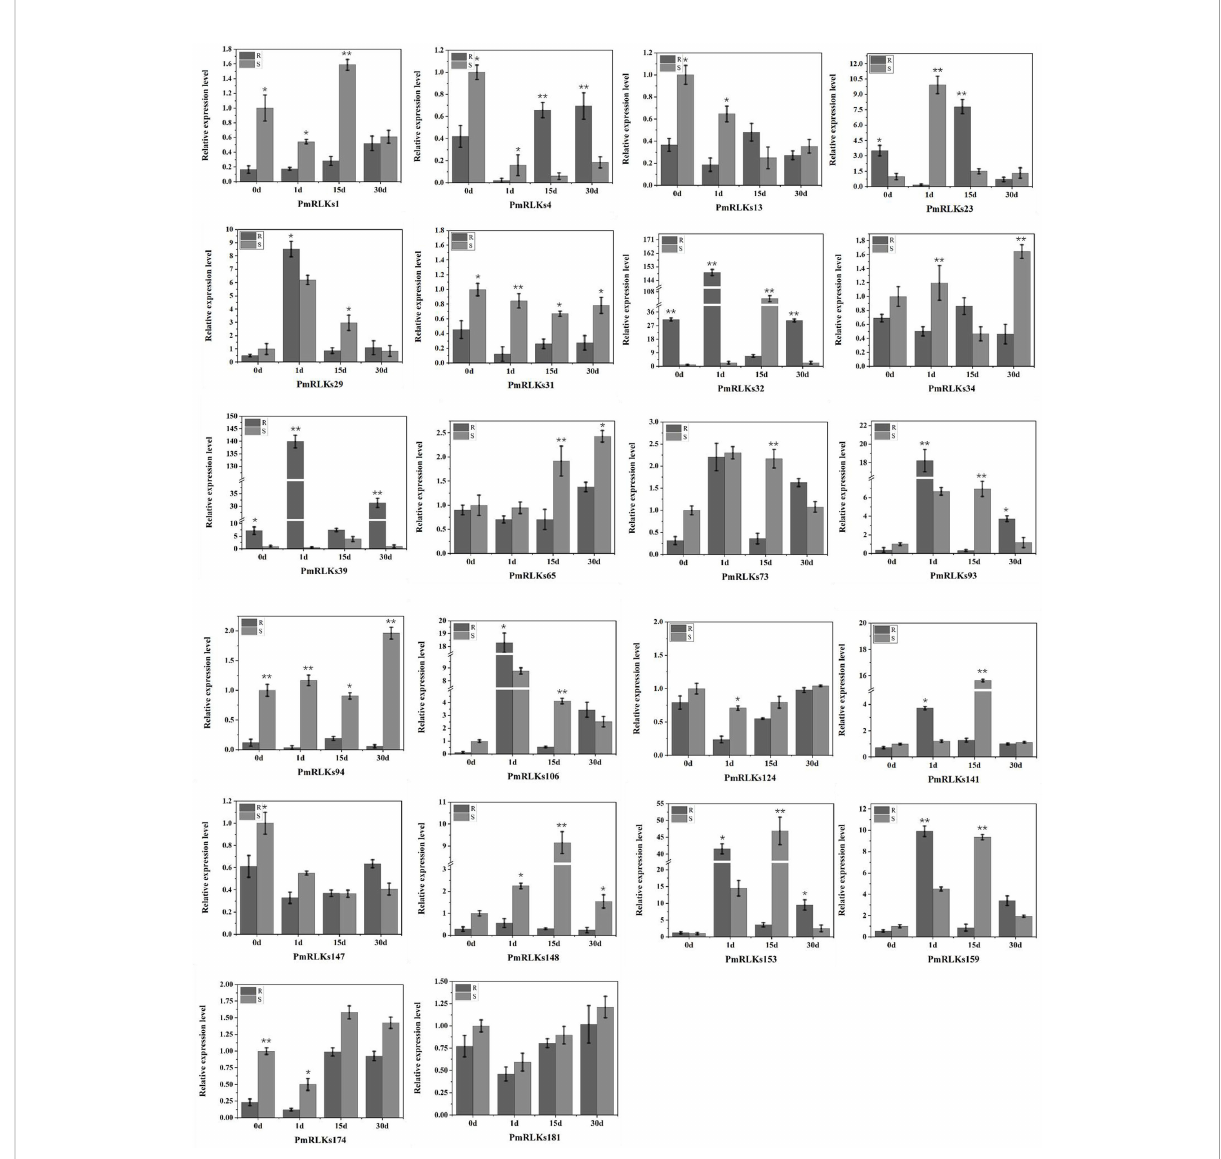
FIGURE 3 Relative expression of PmRLK genes of P. massoniana in response to nematode treatment. The relative expression levels are the log 2 (2 − DD C t ) values. The asterisks indicate signi fi cant differences between each time point of highly resistant (R) and susceptible (S) accessions of P. massoniana . * p < 0.05, ** p <